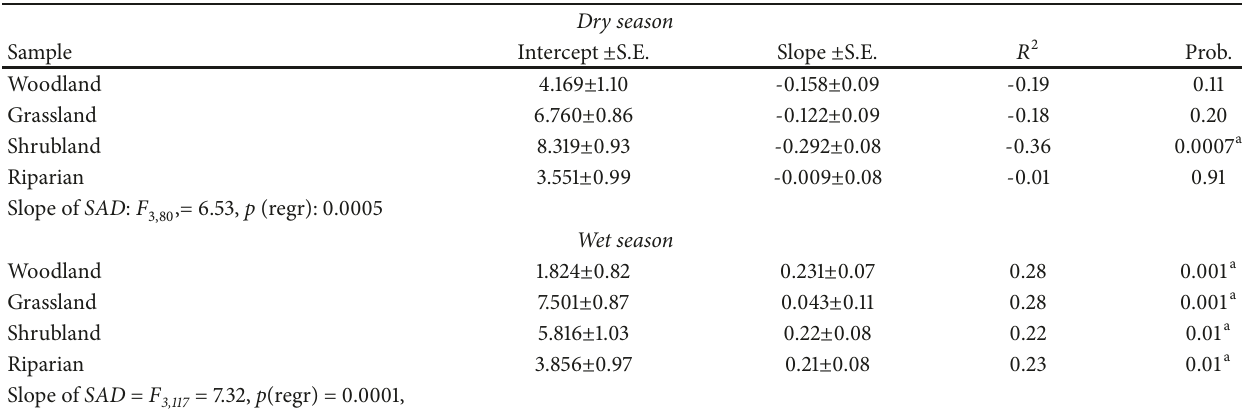
Table 2: Results of the geometric series model for the abundance rank distribution of birds of Mole National Park, calculated for Woodland, Grassland, Shrubland, and Riparian habitats. Levels of significant difference (P-values) were shown with superscript alphabet ( a